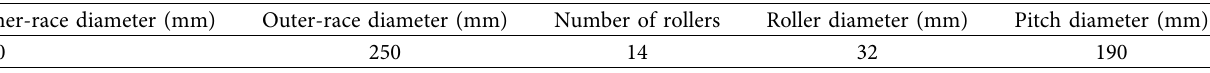
Figure 4: Physical picture of bearing experiment platform. Table 2: Bearing size table (unit: